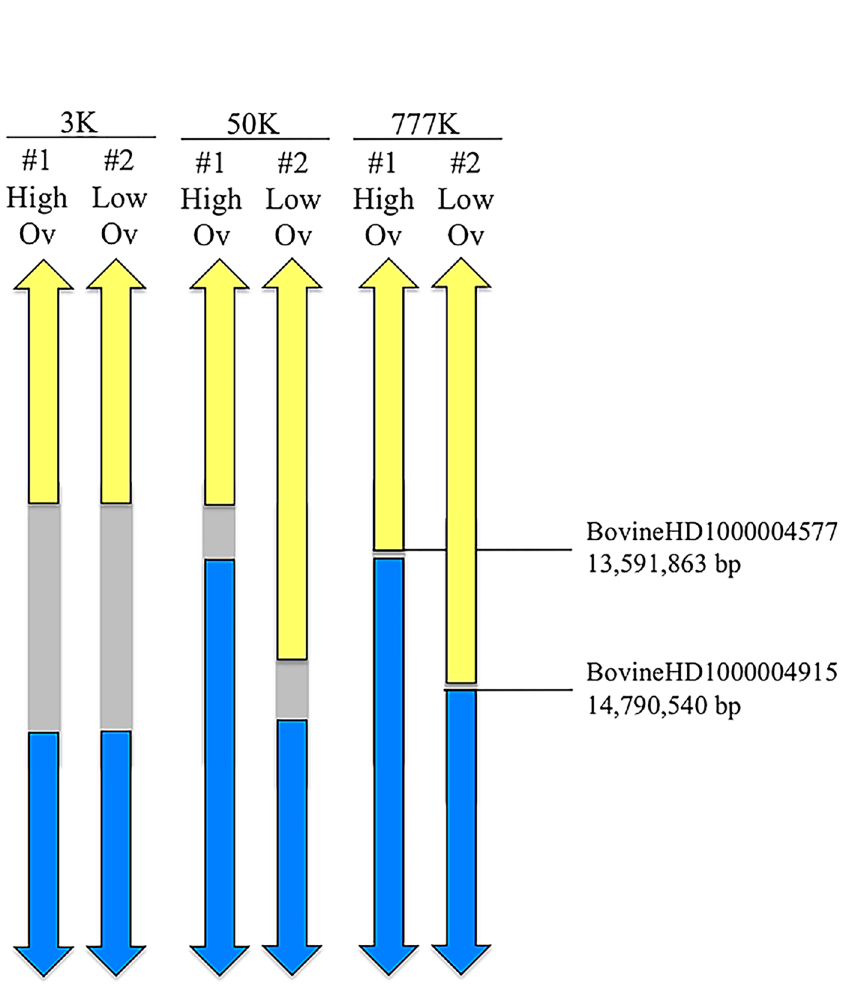
Fig 3. Results for fine-mapping based on the two Trio offspring (denoted #1 and #2) whose recombination breakpoints most narrowly bound the candidate gene region. Upward and downward pointing arrows denote extension of the indicated haplotype to the centromeric and telomeric ends of the chromosome, respectively. Areas in grey denote regions of unknown haplotype. High density genotyping resulted in a narrowing of the candidate gene region to a length of 1.2 Mb bounded by markers BovineHD1000004577 and BovineHD1000004915, as indicated.